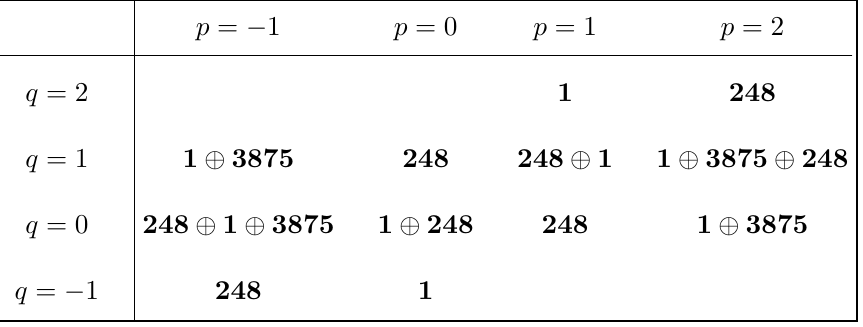
Table 8 . Basis elements of S ( E 9 ). Note the symmetry under ( p; q ) $ (1 (cid:0) p; 1 (cid:0) q ) associated with existence of a bilinear